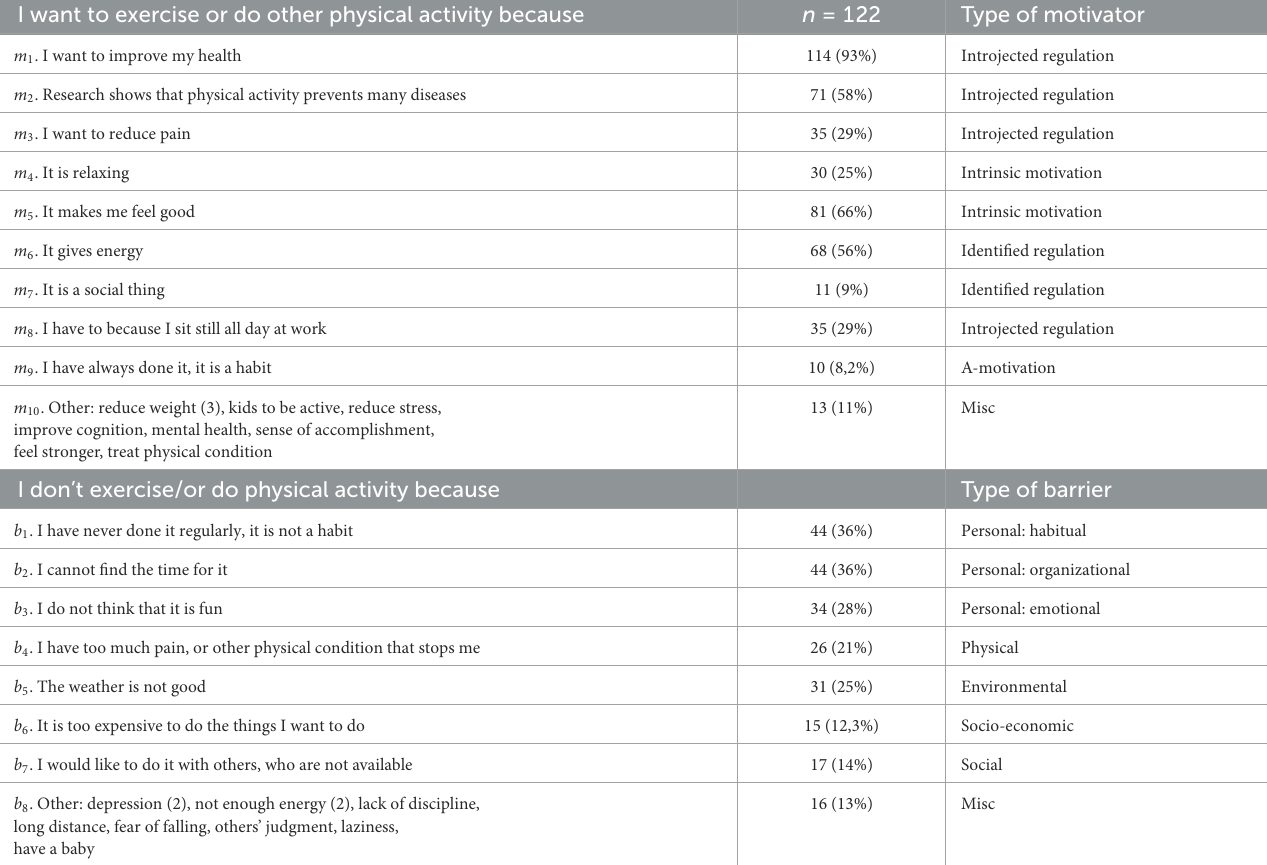
TABLE 5 Participants’ arguments in favor and against changing behavior to increase physical activity. I want to exercise or do other physical activity because n = 122 Type of